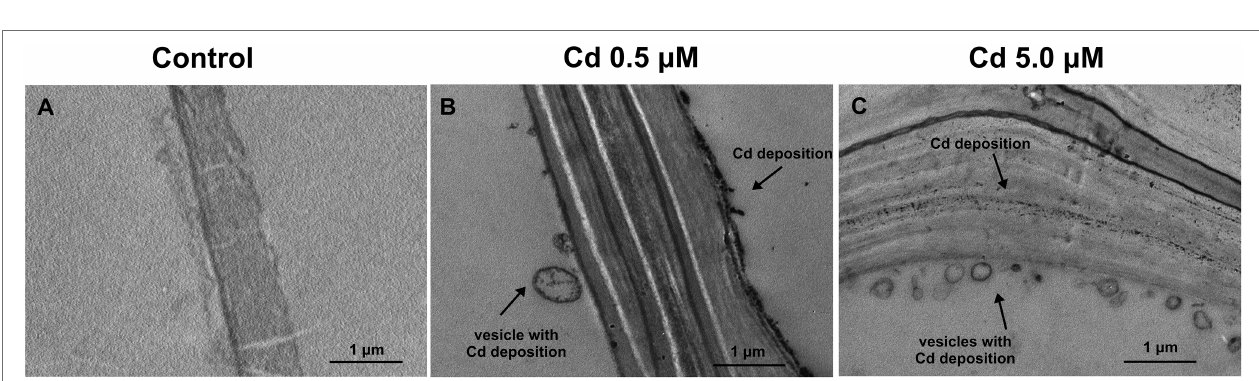
FIGURE 6 | Transmission electron micrographs showing toxic effects of Cd on ultrastructure of roots (15 days from sprouting and from the start of Cd treatments). Panel (A) Control roots; panels (B–D) toxic effects observed in most of root cortical cells treated with Cd. CW, cell wall; G, Golgi apparatus; N, nucleus; ER, endoplasmic reticulum; V, vacuole; and M, mitochondria.